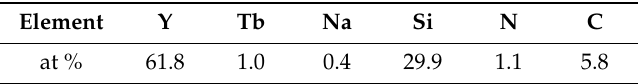
Table 2. Elemental compositions of Y 2 O 3 :Tb 3 + @silica particles functionalized with aminopropyl groups by X-ray fluorescence (XRF) and CHNS analysis.